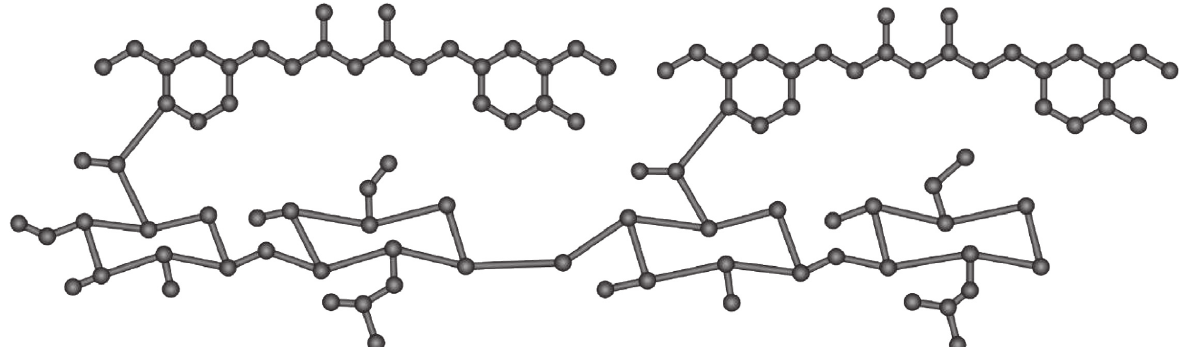
Figure 4: Structure of hyaluronic acid-curcumin conjugate for n �